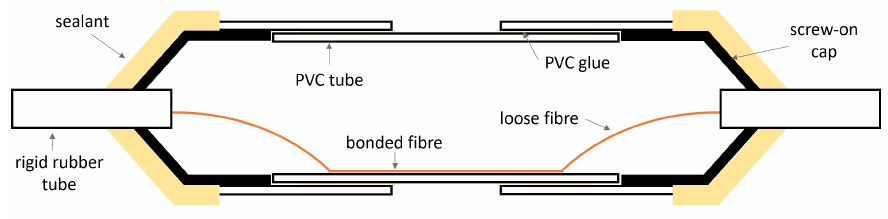
Figure 8. Schematic of the attachment-free fibre-optic pressure sensor described in